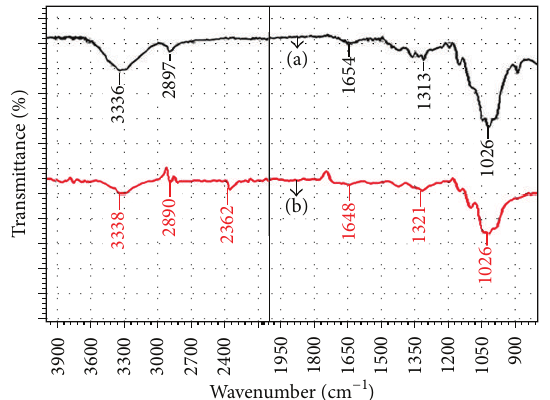
Figure2:FTIRspectraof(a)jutecottonfiberand(b)originalcotton fiber.